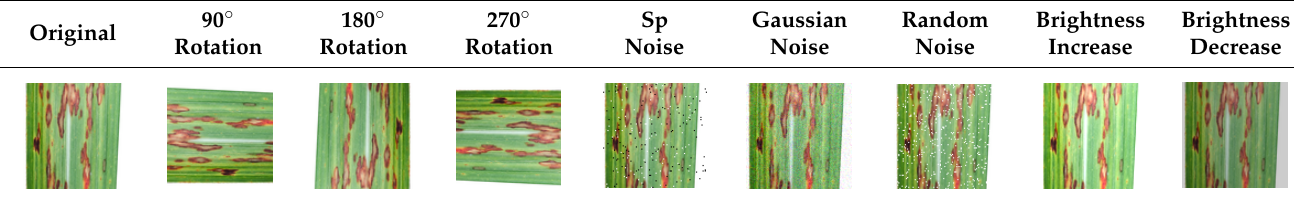
Table 5. Example of supervised data augmentation.